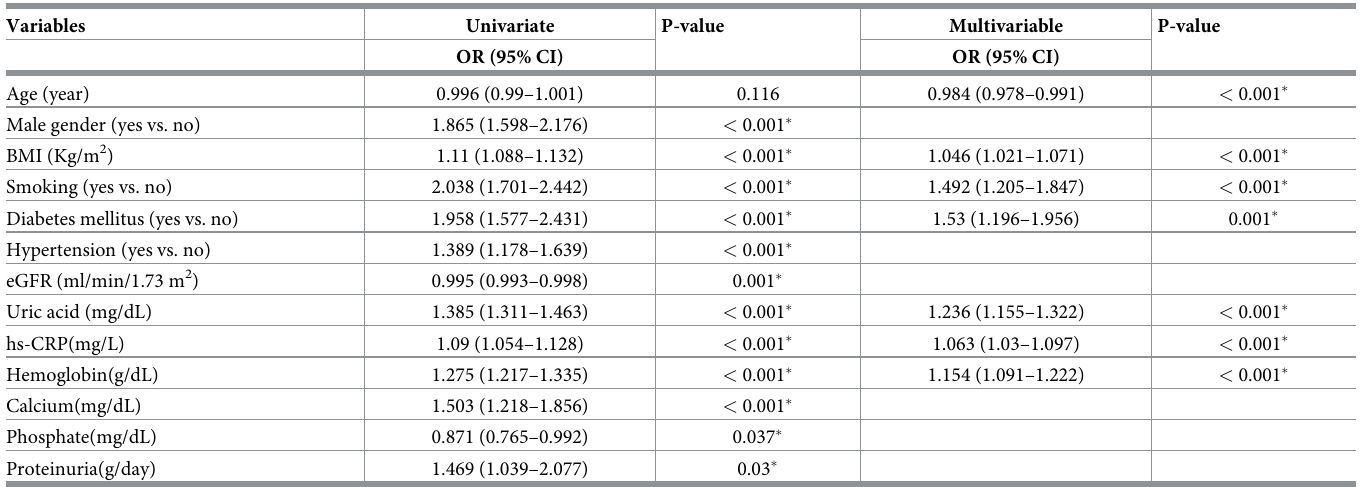
Table 9. Univariate and multivariate analysis of variables associated with higher neutrophil group. Variables